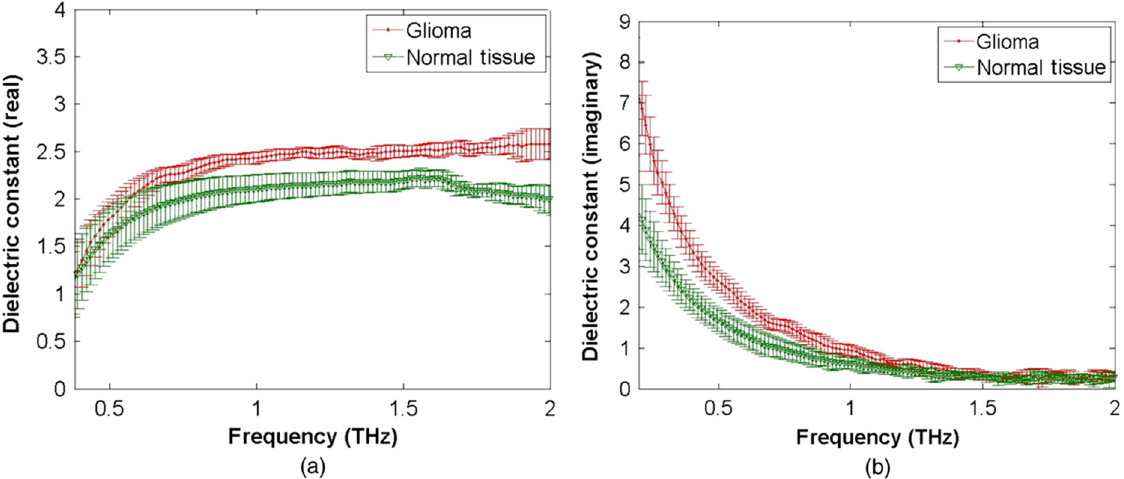
Figure 4. Dielectric constants of glioma and normal brain tissue: ( a ) Real part ε ’ and ( b ) imaginary part ε ”. Adapted from [147].